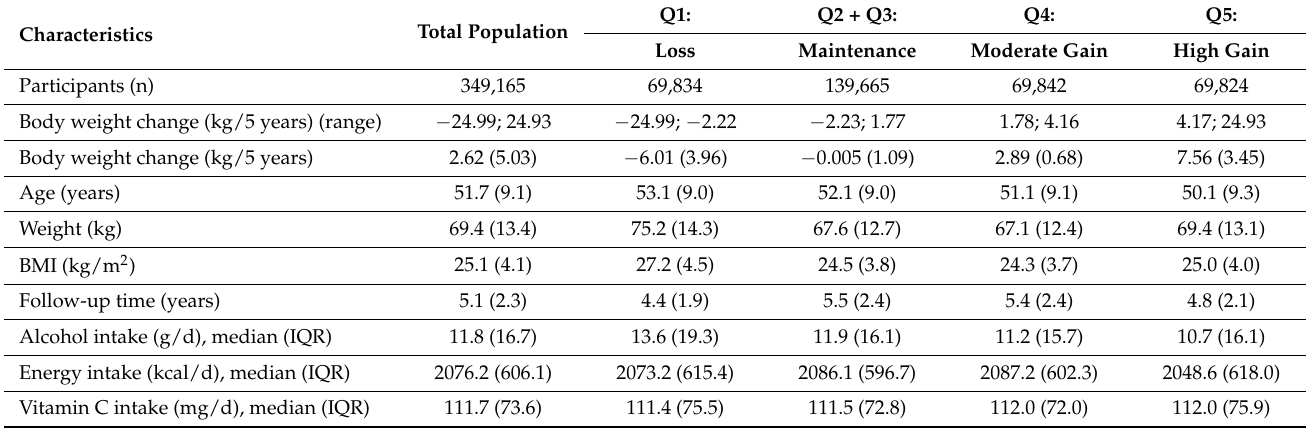
Table 1. Baseline characteristics of the study population by quintiles of body weight change after 5